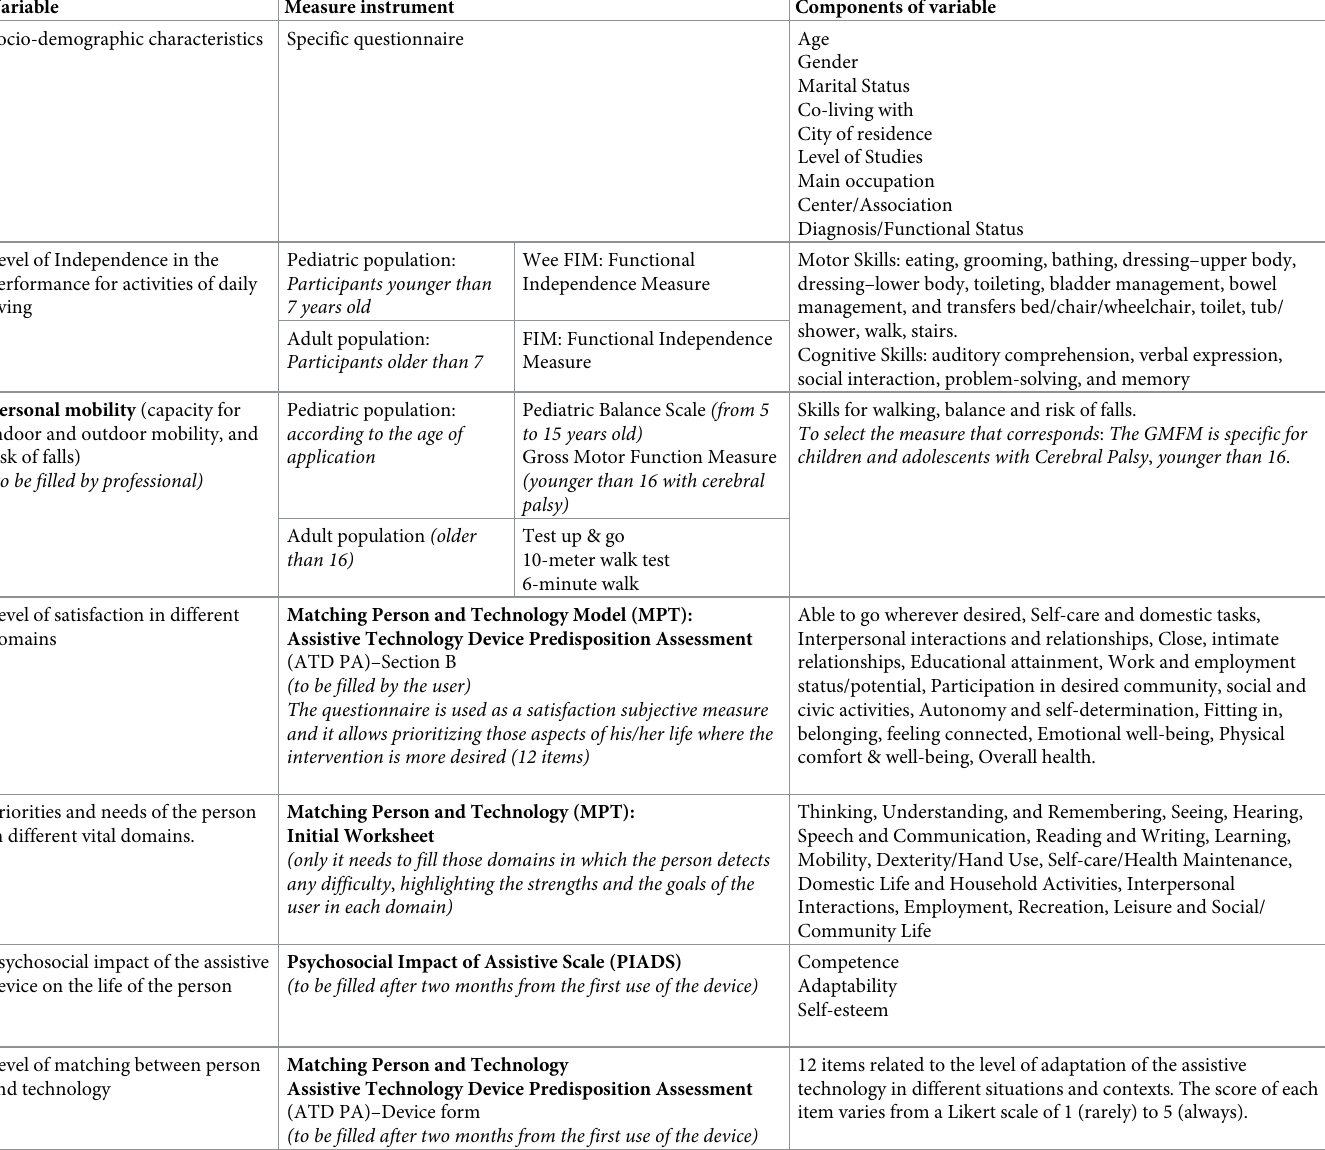
Table 1. Study variables and measure